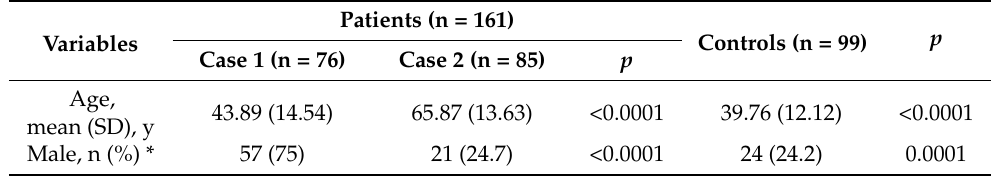
Table 3. Demographic characteristics of the study